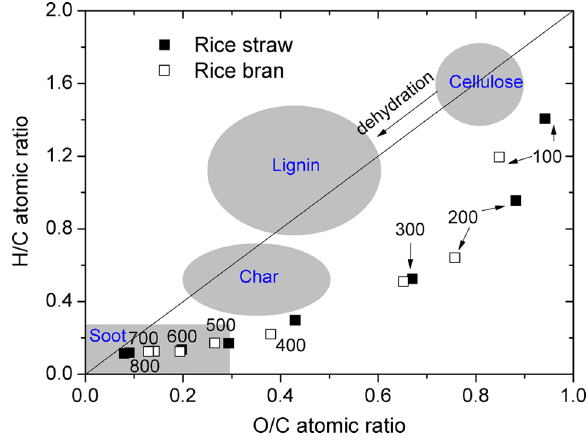
Figure 1. Van Krevelen plot of elemental ratios for rice straw ( & ) and sawdust ( % ) derived biochars prepared at various charring temperatures. Thick line represents the direction for dehydration reactions and grey shadings highlight approximate elemental ratios of unaltered biomacromolecules (cellulose and lignin) and black carbon materials (char and soot) following Hammes et al.